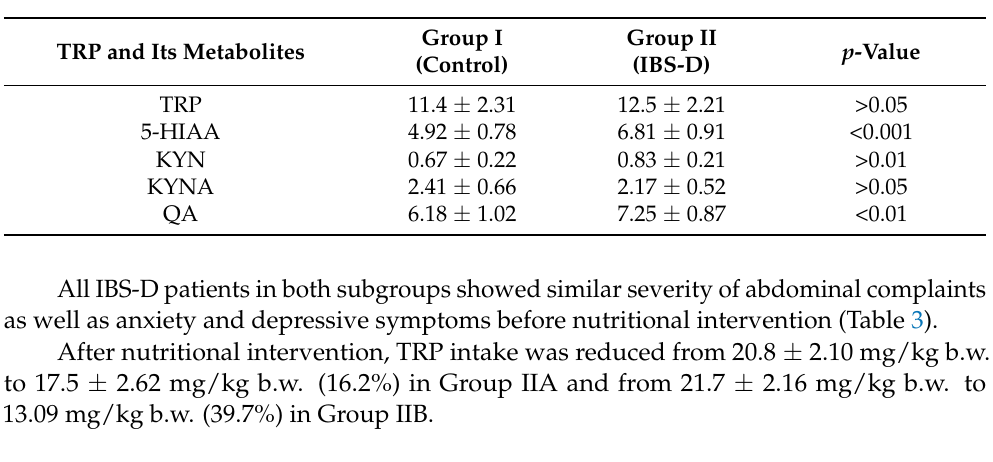
Table 2. Urinary levels of tryptophan (TRP) and its metabolites: 5-hydroxyindoleacetic acid (5- HIAA), kynurenine (KYN), kynurenic acid (KYNA), and quinolinic acid (QA) in the control group and patients with diarrhea-predominant irritable bowel syndrome (IBS-D); all results expressed in units—mg/gCr; average ±